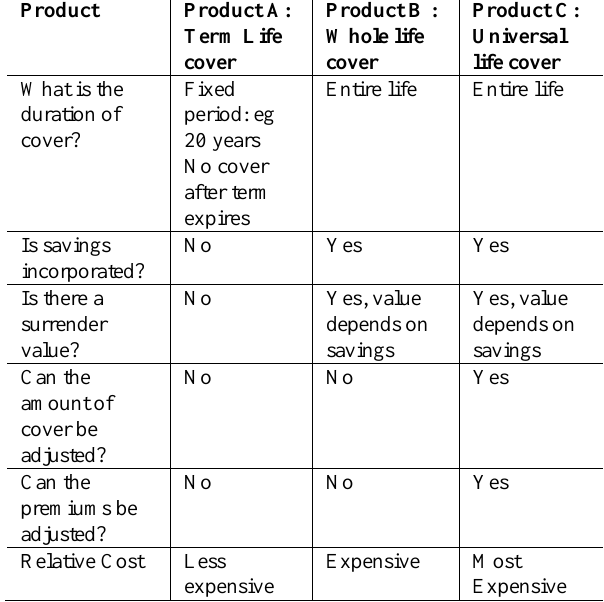
Table 8: features of basic insurance